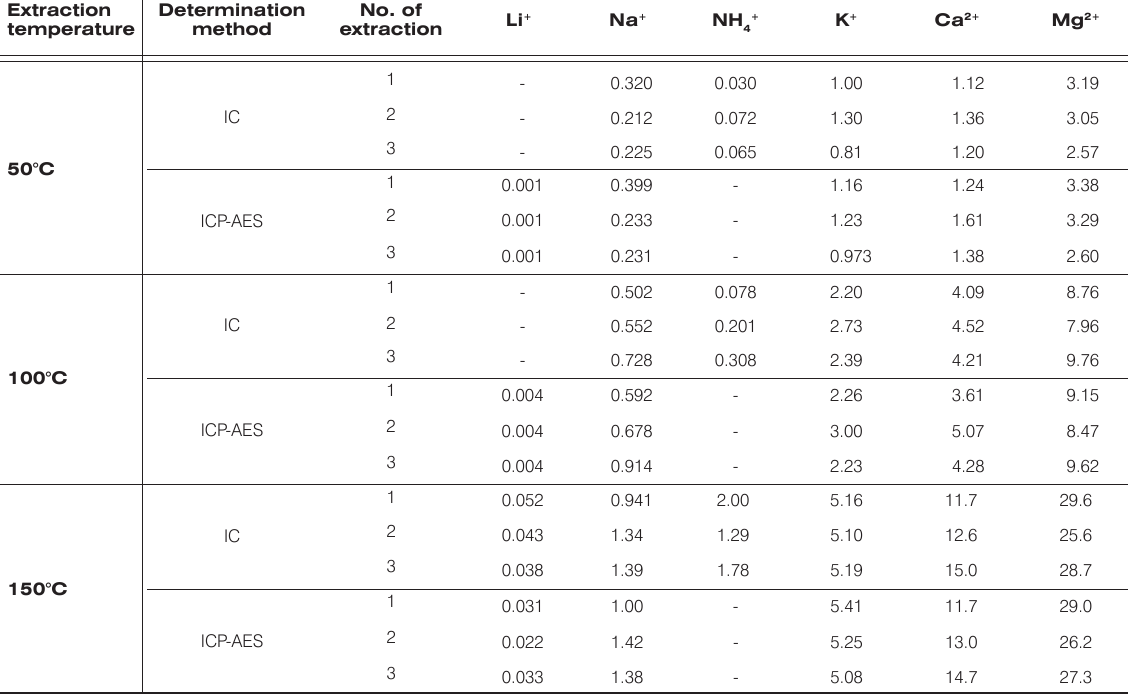
Table 7. The results of determinations of total ion content of Cd, Co, Cr, Cu and Fe obtained by ICP-AES, after three extraction techniques (μg/100 g soil). Extraction